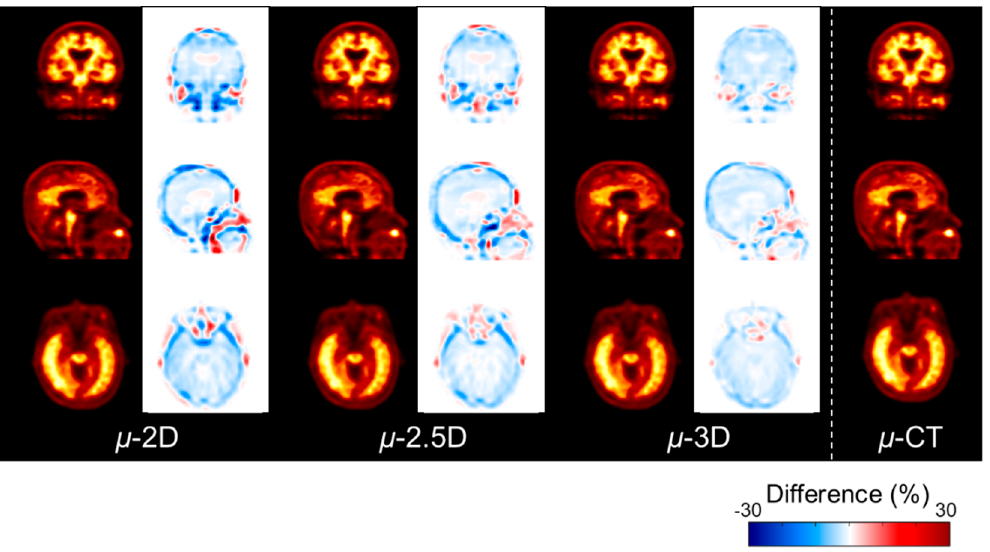
Figure 5. Activity images in standard uptake value (SUV) corrected for attenuation using different μ -maps and SUV error maps relative to the ground truth (image corrected using μ -CT). The smallest SUV error was obtained using μ -3D.